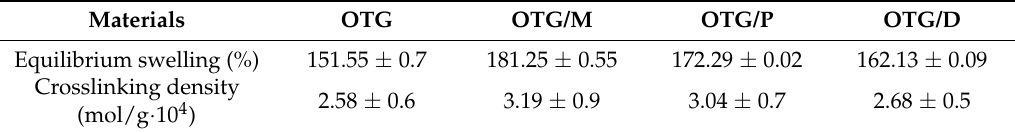
Table 2. Swelling and crossing density characteristics of elastomer vulcanizates.